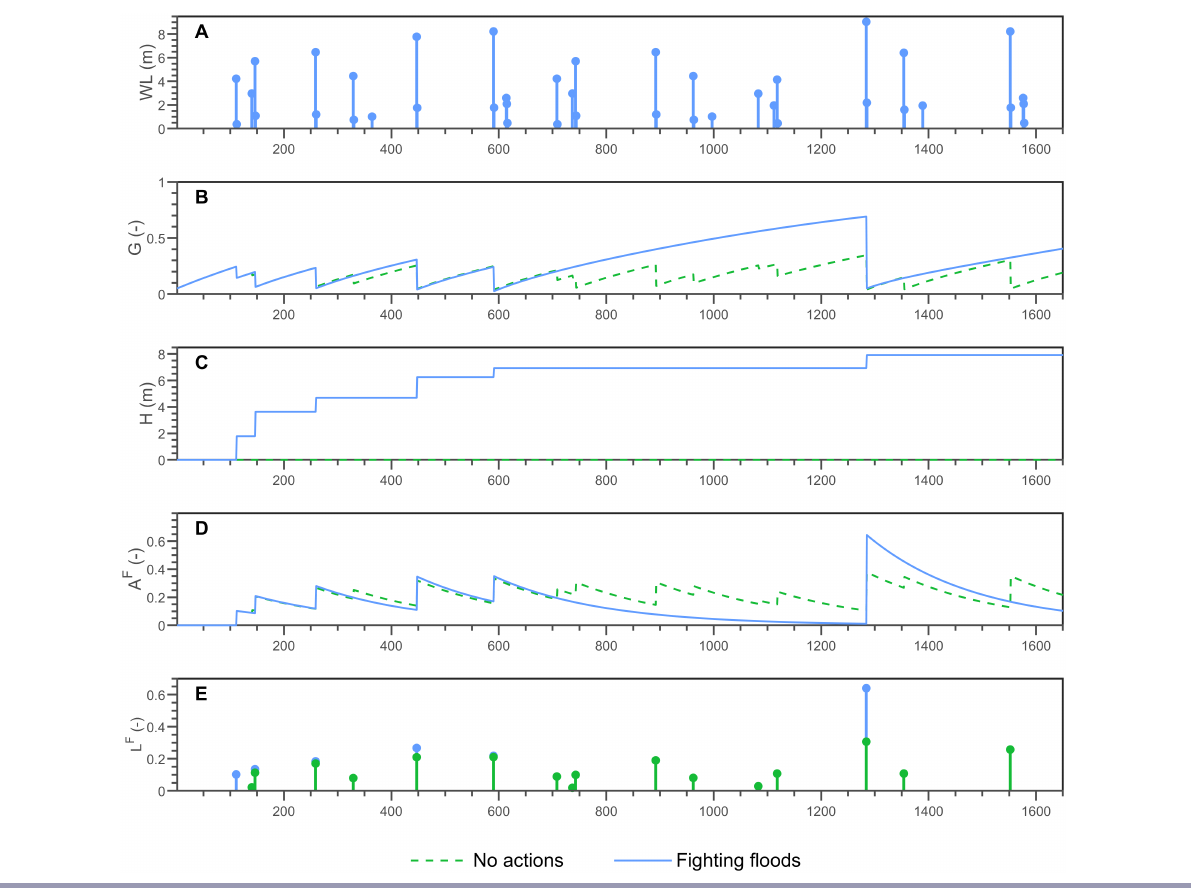
Fig. 6 . Numerical experiments considering only human-flood interaction and no dam construction with the baseline and fighting-floods strategies. (A) Water level (WL), (B) proportion of